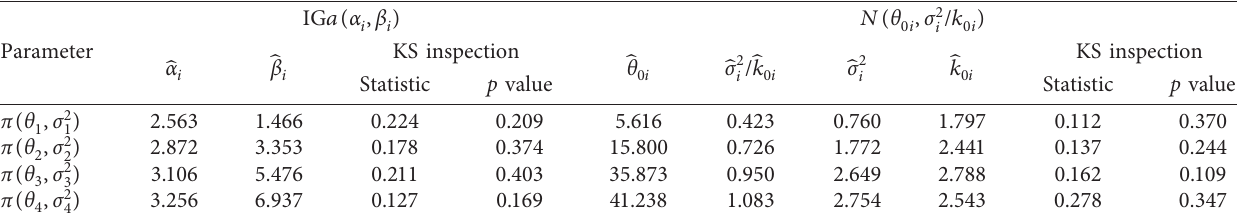
Table 4: Hyperparameters of prior distribution.